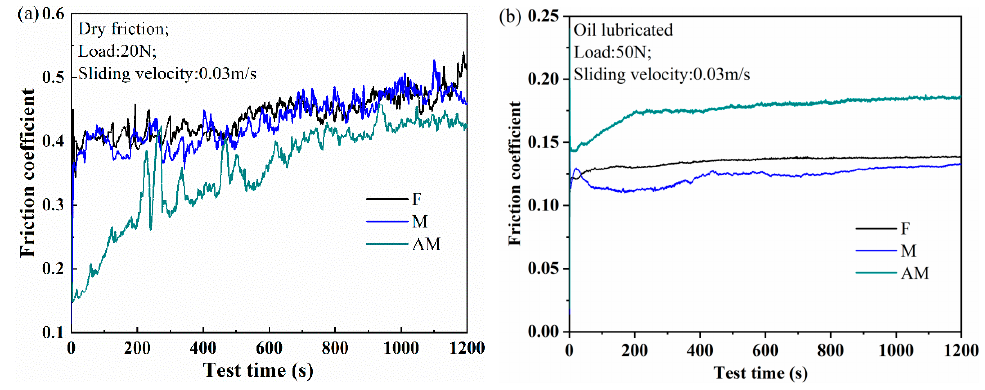
Figure 8. Frictional coefficients varying with running time under ( a ) dry sliding; ( b ) oil-lubricated